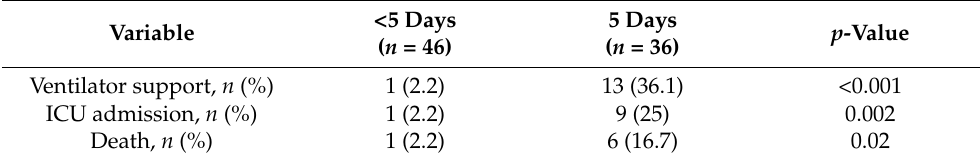
Table 5. Outcome comparison between kidney transplant recipients treated with sotrovimab early in the onset of symptoms and those treated late